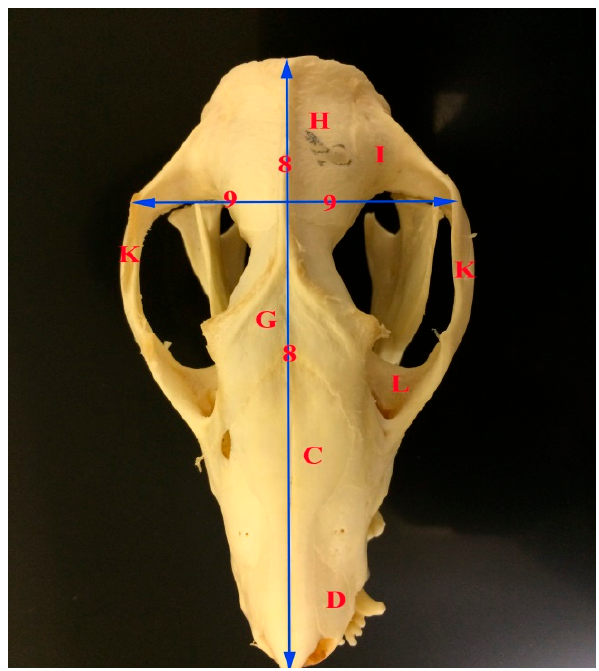
Figure 3. Photograph of dorsoventral view of the skull of the common opossum showing the skull measures. C nasal bone; D incisive bone; G frontal bone H Parietal bone; I temporal bone; K zygomatic arch; L orbit; 8 facial length; and, 9 facial width.